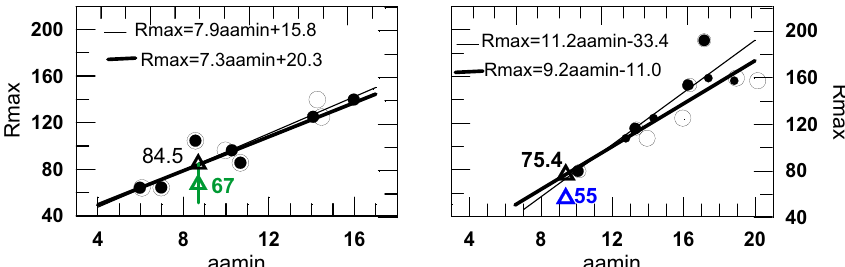
Fig. 7. Sunspot maximum data, R max vs. geomagnetic index data aa min . The latter have been taken from the standard time series (open circles, thin regression line) and the Lockwood time series (filled circles, thick regression line). The left- and right-hand panels are for the Regular Episode (sunspot cycles #9 to #25) and for the Grand Maximum (sunspot cycles #16 to #23), respectively. The abscissa values of the green (left) and the red (right) stars are our predictions from the standard aa min data (De Jager & Duhau 2009) and for the Lockwood data (Duhau & De Jager 2010), respectively. The ordinate values are those of the corresponding open triangles in Figure 3. The error bar is included in the left- hand